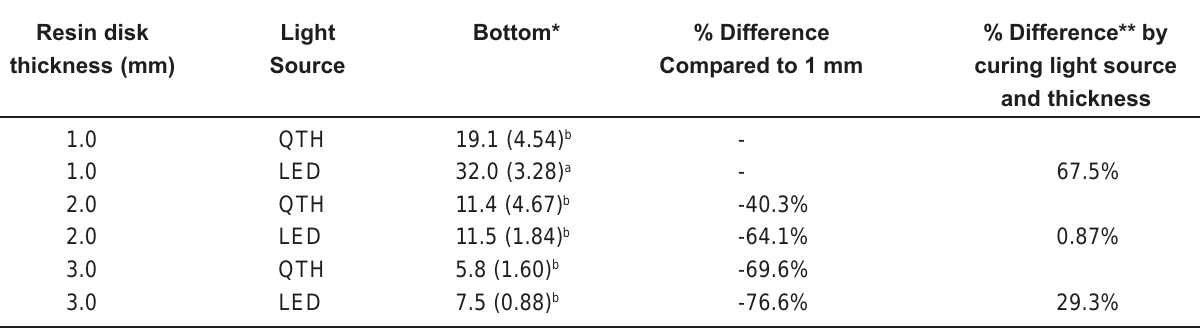
*The same superscripted letters indicate no significant differences (p > 0.05). **Absolute difference in mean VHN/ mean QTH VHN.